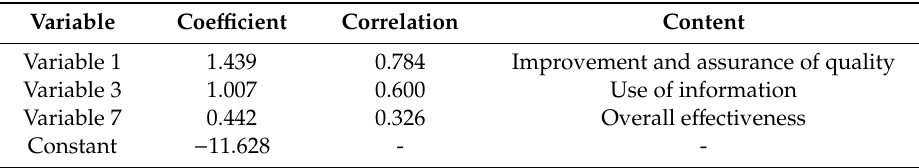
Table 16. The unstandardised coe ffi cients and